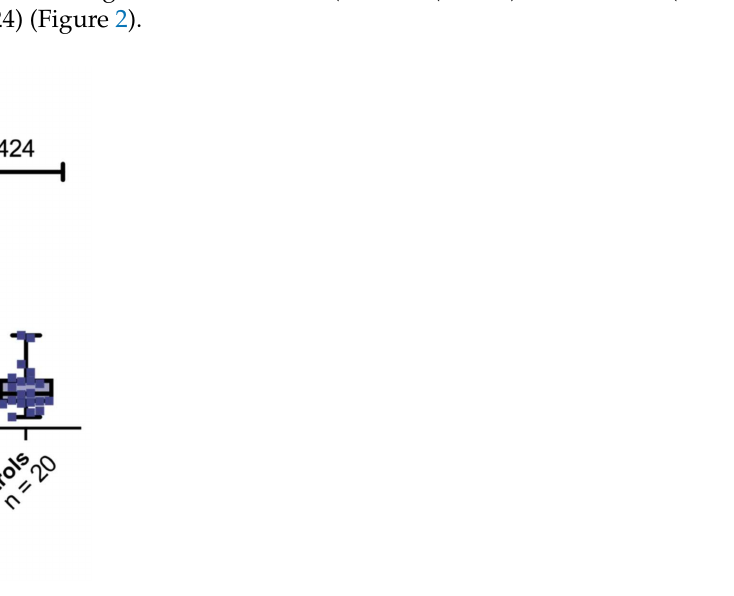
Figure 2. VEGF-A serum concentrations between groups. The bars represent the median with interquartile range (first quartile and third quartile) and whiskers from min to maximum values. VEGF-A serum concentration in exudative AMD group: 422.674 (677.02) pg/mL and control group: 615.489 (425.49) pg/mL. Mann–Whitney-U test, p =